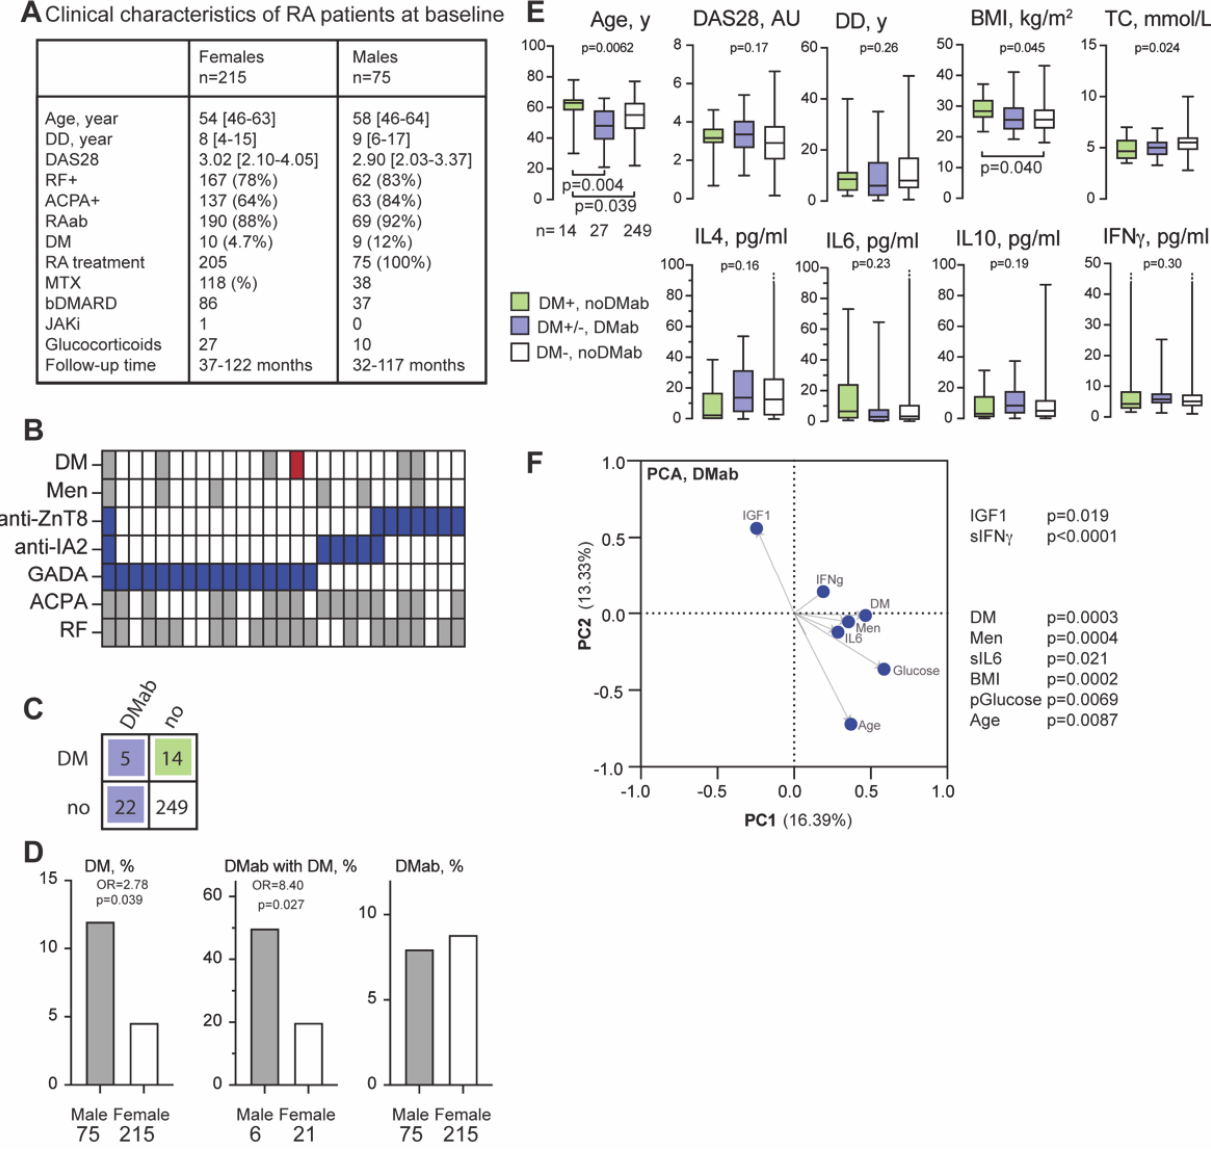
Figure 2. Clinical associates of DM-specific antibodies in RA patients. ( A ) Clinical characteristics of RA patients at baseline. ( B ) Heatmap of DM, rheumatoid factor (RF), antibodies-to-cyclic-citrullinated peptides (ACPA), and gender distribution among the patients with the DM antibodies GADA, anti-ZnT8, and anti-IA2. Red box indicates a case with new DM. ( C ) A 2 × 2 table of coexistence between DM and DMab. ( D ) Bar graphs showing the frequencies of DM, DMab with DM, and DMab in men and women. ( E ) Box plots of clinical and serological variables in patients with DM without DMab ( n = 14, green), in patients with DMab with and without DM ( n = 27, blue), and in patients without DM and DMab ( n = 249, white). ( F ) Scatter plot of principal component analysis (PCA) shows variables associated with DMab. Significantly associated variables are indicated with p -value (calculated with least-squares regression). Box plots present median interquartile range, the whiskers indicate min and max values except for when the max is very high (indicated with a line becoming a dotted line). p -values were calculated with mixed exact chi-square test and the Kruskal–Wallis test, followed by Dunn’s multiple comparisons test. AU, arbitrary units; BMI, body mass index; DD, disease duration; DM, diabetes mellitus; TC, total cholesterol.